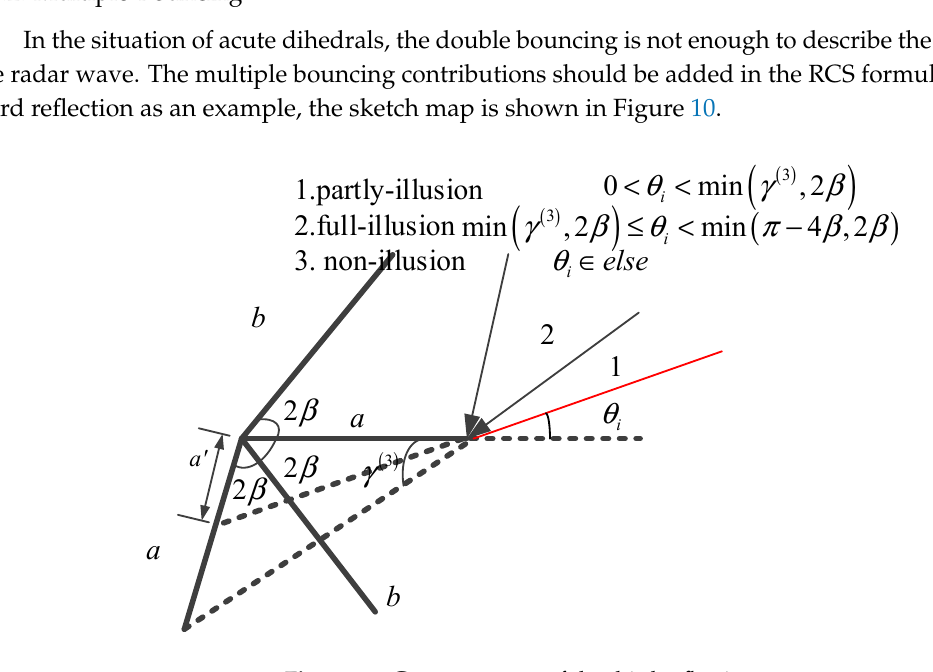
Figure 10. Geometry map of the third reflection.